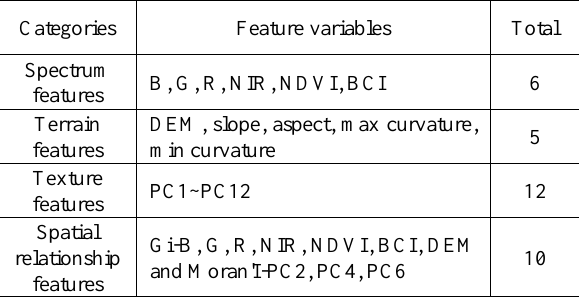
Table 1. Statistic of feature